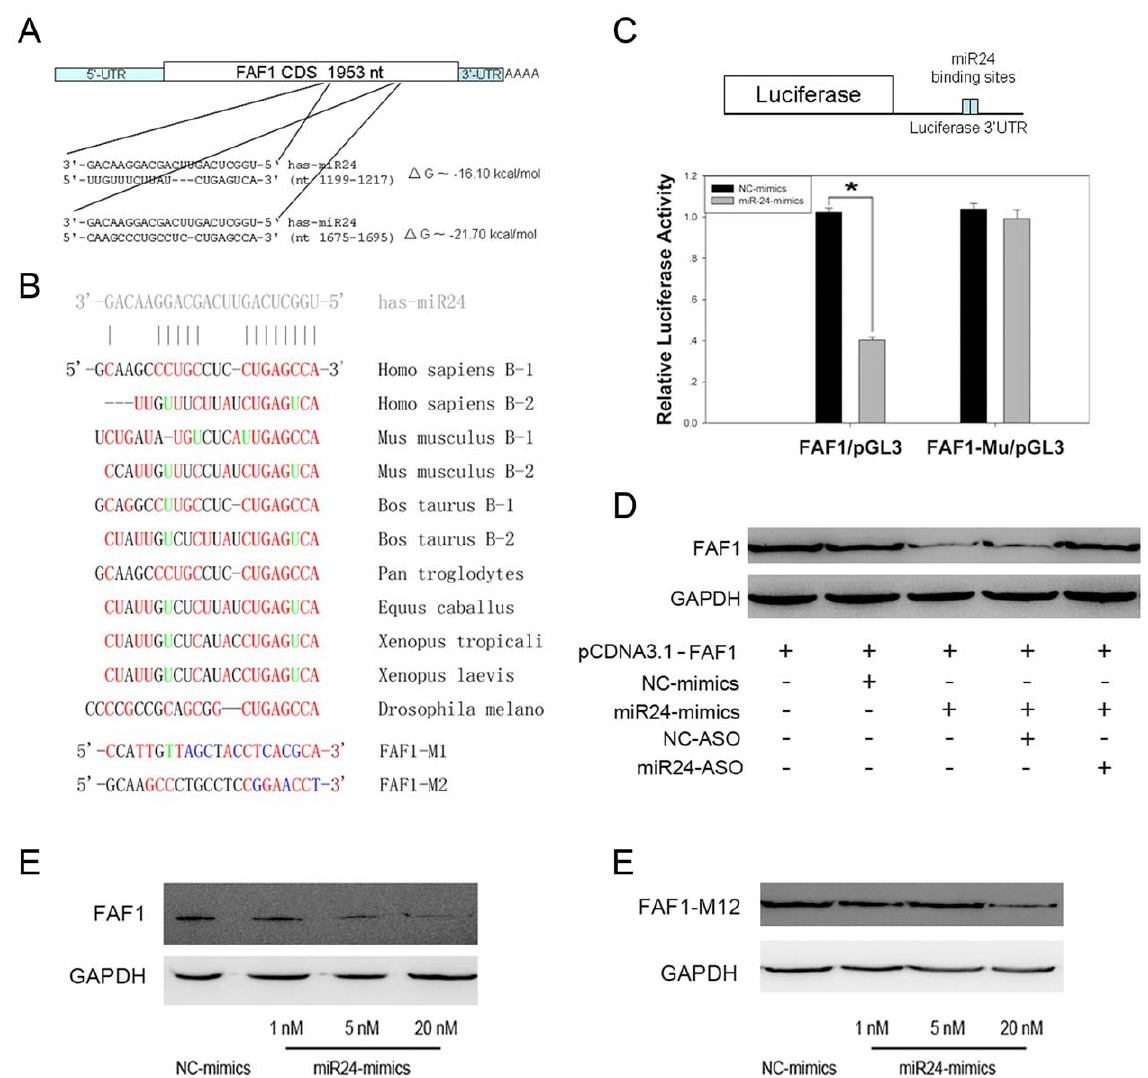
Figure 2. miR-24 regulates FAF1 by targeting its ORF region. (A) RNA22 software was used to predict that the CDS region of FAF1 mRNA harbors two putative miR-24 binding sites. The sequence of miR-24, its binding sites, and energies are shown. (B) The predicted binding sites of FAF1 were conserved in eight different species. The bases altered in the mutant FAF1 constructs are also shown. Red: paired bases; green: G:U pair; blue: mutant bases. (C) 293T cells were transfected with a reporter vector consisting of a luciferase gene containing the wild type or mutated miR-24 binding sites) in its 3 9 -UTR region (FAF1/pGL3 or FAF1-M12/pGL3, 20 ng/well in each 24-well plate). The cells were also transfected with a CMV-Renilla luciferase vector (20 ng/well in each 24-well plate) as an internal standard. Expression of the luciferase containing predicted miR-24 binding sequences was decreased by treatment with 20 nM miR-24-mimic compared to treatment with NC-mimic, while the luciferase containing mutated sequences could not be down-regulated (n=3 6 SE; * p , 0.01). (D) miR-24 regulates the FAF1 gene. 293T cells were treated as indicated and transfected with 100 ng pcDNA3.1-FAF1. The expression of FAF1 was down-regulated after transfection with 20 nM miR-24-mimic and rescued after 100 nM miR-24-ASO being transfected. (E) Dose-dependent suppression of FAF1 by miR-24 in 293T cells. 293T cells were co-transfected with 100 ng pcDNA3.1-FAF1 and 1, 5, or 20 nM miR-24-mimic after 24 h and immunoblotted as above. (F) Mutant FAF1 could not be down-regulated upon transfection with 1 nM or 5 nM of miR-24-mimic for 24 h. FAF1 was down-regulated slightly after transfection with 20 nM miR-24-mimic; this might because the mutation to FAF1 was somewhat small.